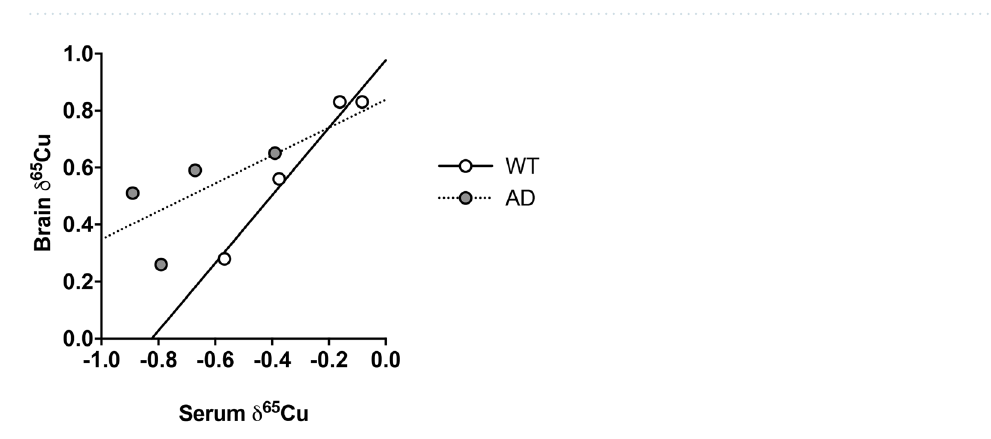
Figure 1. Copper isotopic composition of serum and brain in wild type mice. The data are reported as δ 65 Cu, which is the per mil deviation of the 65 Cu/ 63 Cu from the NIST 976 standard. ( A ) Evolution of δ 65 Cu in serum of individual mice are shown over time (males are shown in blue and female in red). ( B ) Pooled data for δ 65 Cu in serum: boxes extend from the 25 th and 75 th percentile, the line in the middle of the box represents the median, and the whiskers show the minimum and the maximum. Two-way ANOVA showed a significant effect of sex (p < 0001). p values between males and females are indicated on the graphic for each age (Sidak’s multiple comparison test). Wilcoxon matched-pairs rank test were used to compare females of different ages (p = 0.06 when comparing 3- and 12-month-old females). ( C ) Comparison of δ 65 Cu in serum and brain from 12-month- old females. p = 0.06, Wilcoxon matched-pairs rank test.